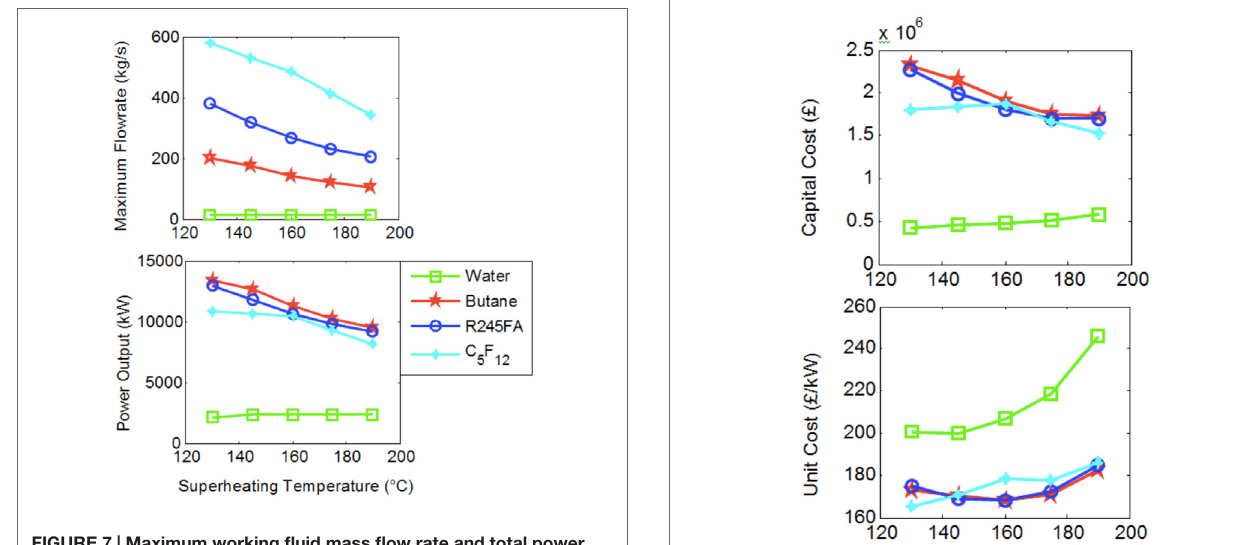
FiGURe 7 | Maximum working fluid mass flow rate and total power output from Rankine cycles with water and indicated organic fluids over a range of maximum cycle temperatures, T 3 . Results correspond to the same conditions given in Figures 5 and 6 . Water results are shown only for expansion down to (and condensation at) 1